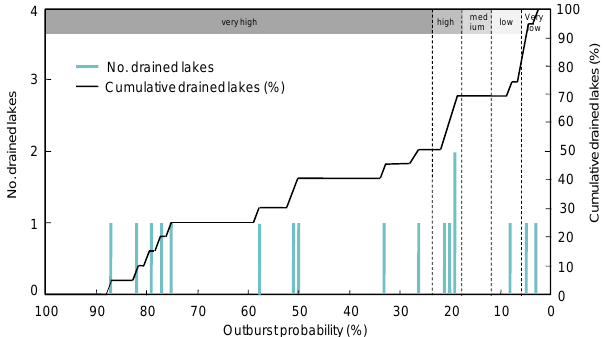
Figure 3 Distribution of outburst probability estimates for drained lakes in southwestern British 428 Fig. 3. Distribution of outburst probability estimates for drained Columbia. The black curve is the cumulative percentage of drained lakes based on outburst 429 lakes in southwestern British Columbia. The black curve is the cu- probability estimates. Breaks in the slope of this curve, for example at 6%, provide an objective 430 mulative percentage of drained lakes based on outburst probability basis for defining probability categories (top of graph) (McKillop et al., 2007b). 431 estimates. Breaks in the slope of this curve, for example at 6%, 432 provide an objective basis for defining probability categories (top of graph) (McKillop et al., Generally speaking, as a potentially dangerous lake is about to breach, the accumulation of 434 water of the lake basin gradually approaches maximum levels, and the hazard parameters should 435